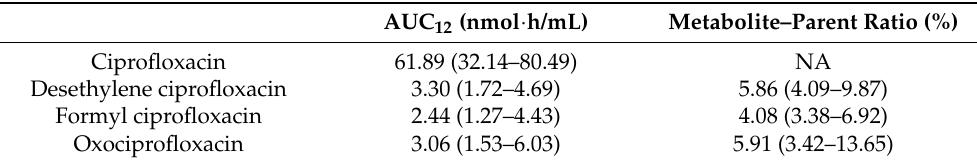
Table 3. Ciprofloxacin, desethylene ciprofloxacin, formyl ciprofloxacin and oxociprofloxacin: 12-h exposure (AUC 12 ) and metabolite–parent drug ratios.